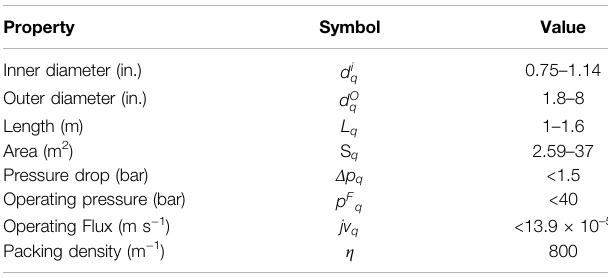
TABLE 6 | Ranges of module